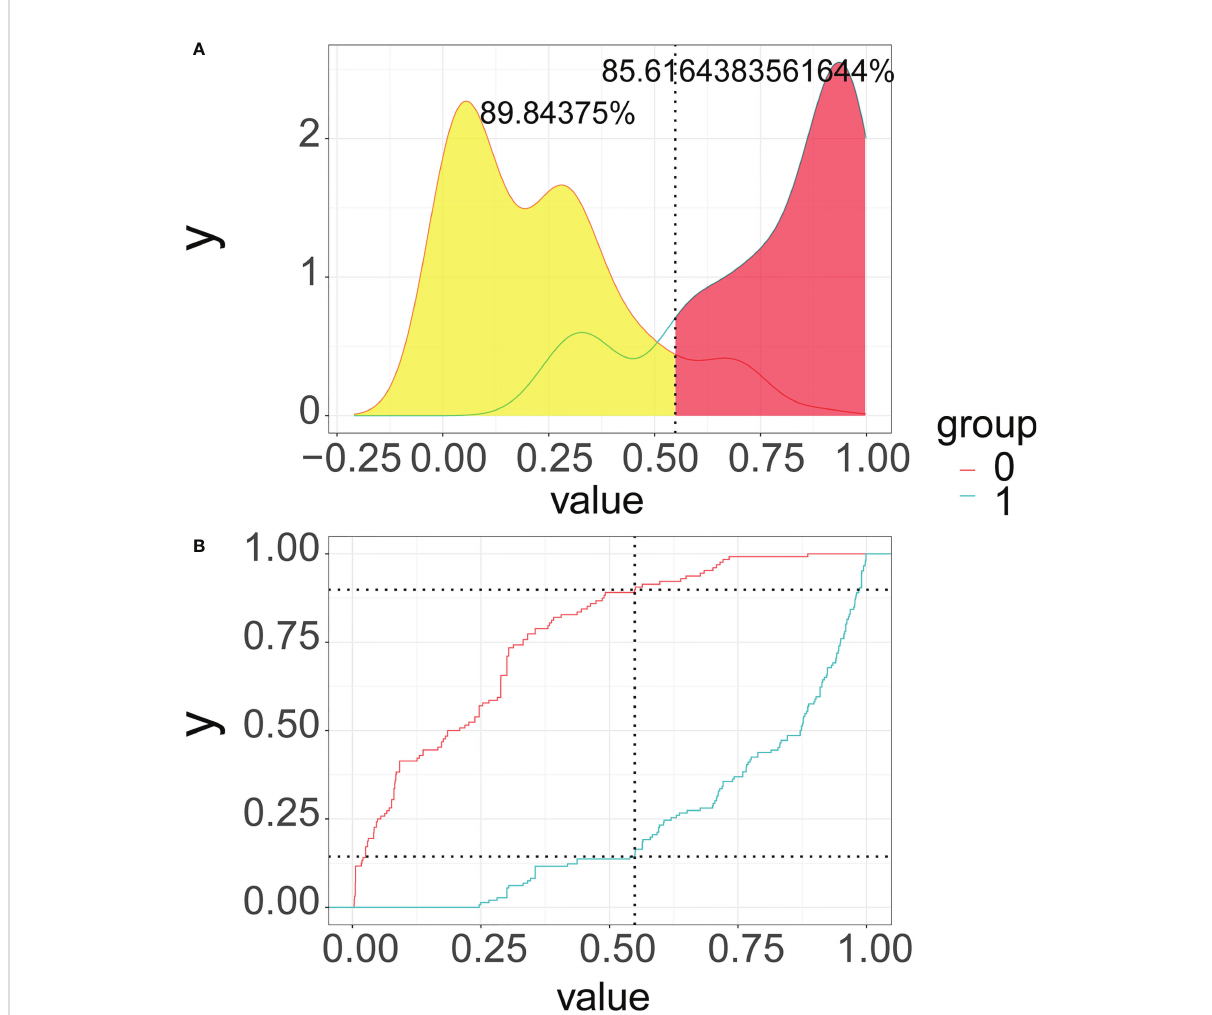
FIGURE 7 Probability density functions (A) and c linical utility curves (B) of the predictive model (0, benign modules group; 1, malignant nodules group). It is 85.6% (red area under the blue line) of malignant nodules, and the number of biopsy procedures for benign nodules was reduced by 89.8% (yellow area under the red